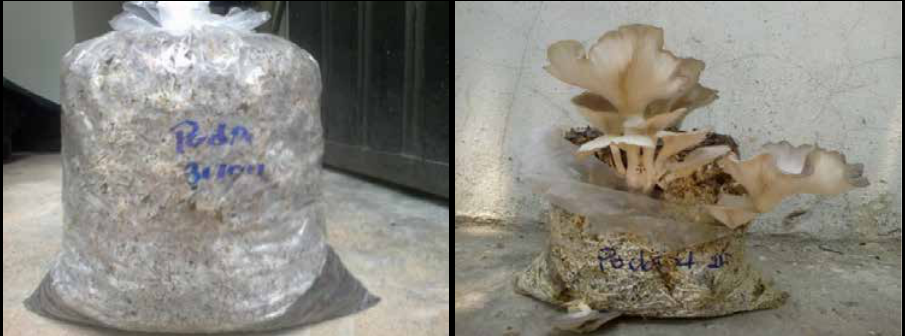
Fig. 8: Mycelial growth and fruiting bodies of Pleurotus sp . on pruning